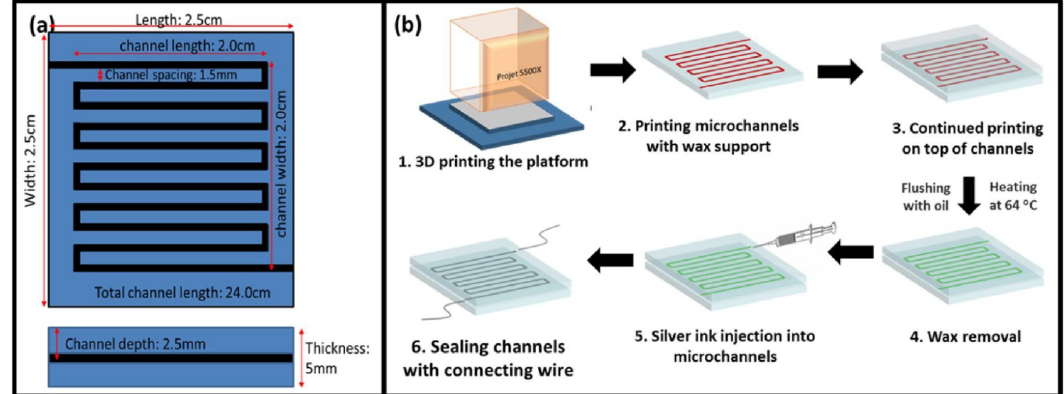
Figure 2. (a) Schematic depicting design and dimensions of microchannels. ( b ) Complete fabrication process of printed strain sensor. Reproduced with the permission of Reference [12]. Copyright 2017 Elsevier.